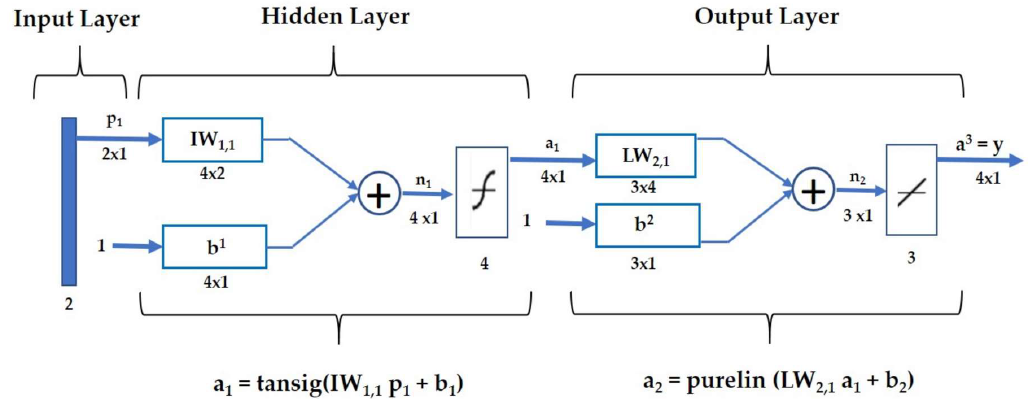
Figure 4. This diagram illustrates the structure of a conventional feed-forward back-propagation network model neural network model